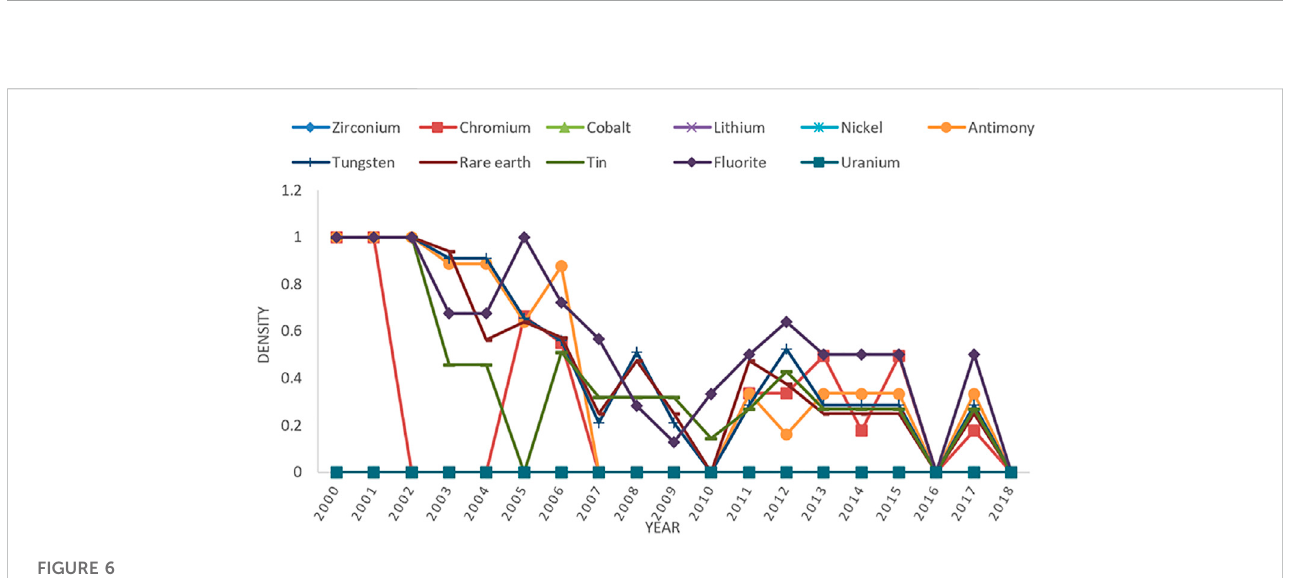
FIGURE 6 Density of China ’ s strategic and critical mineral